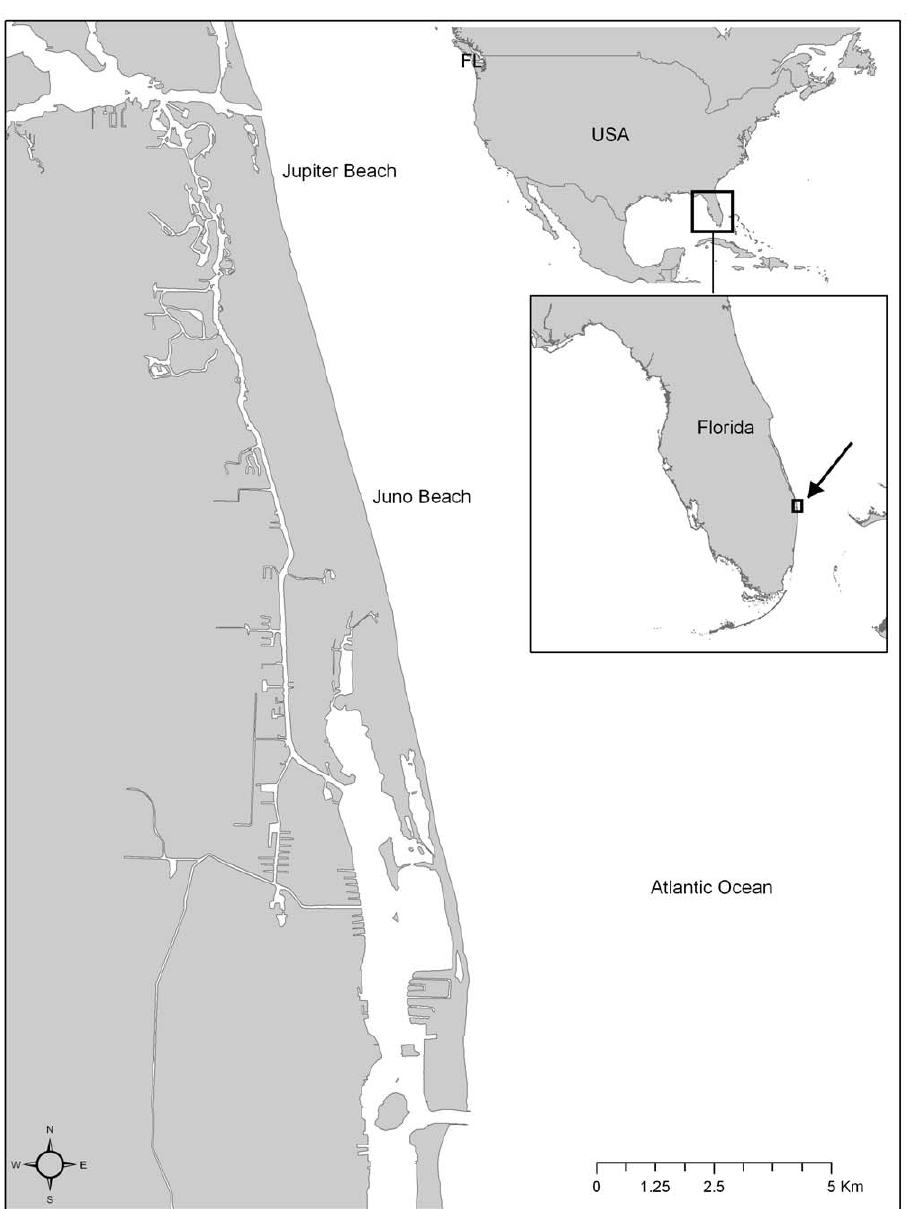
Figure 1. Map of the nesting beach extending across Juno Beach and Jupiter Beach, Florida, USA.